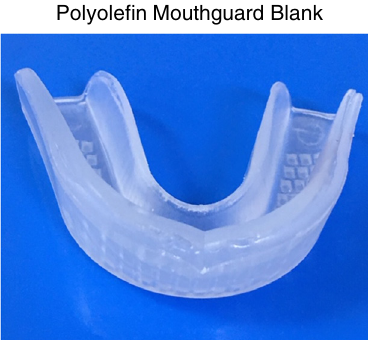
Figure 10. Polyolefin mouthguard